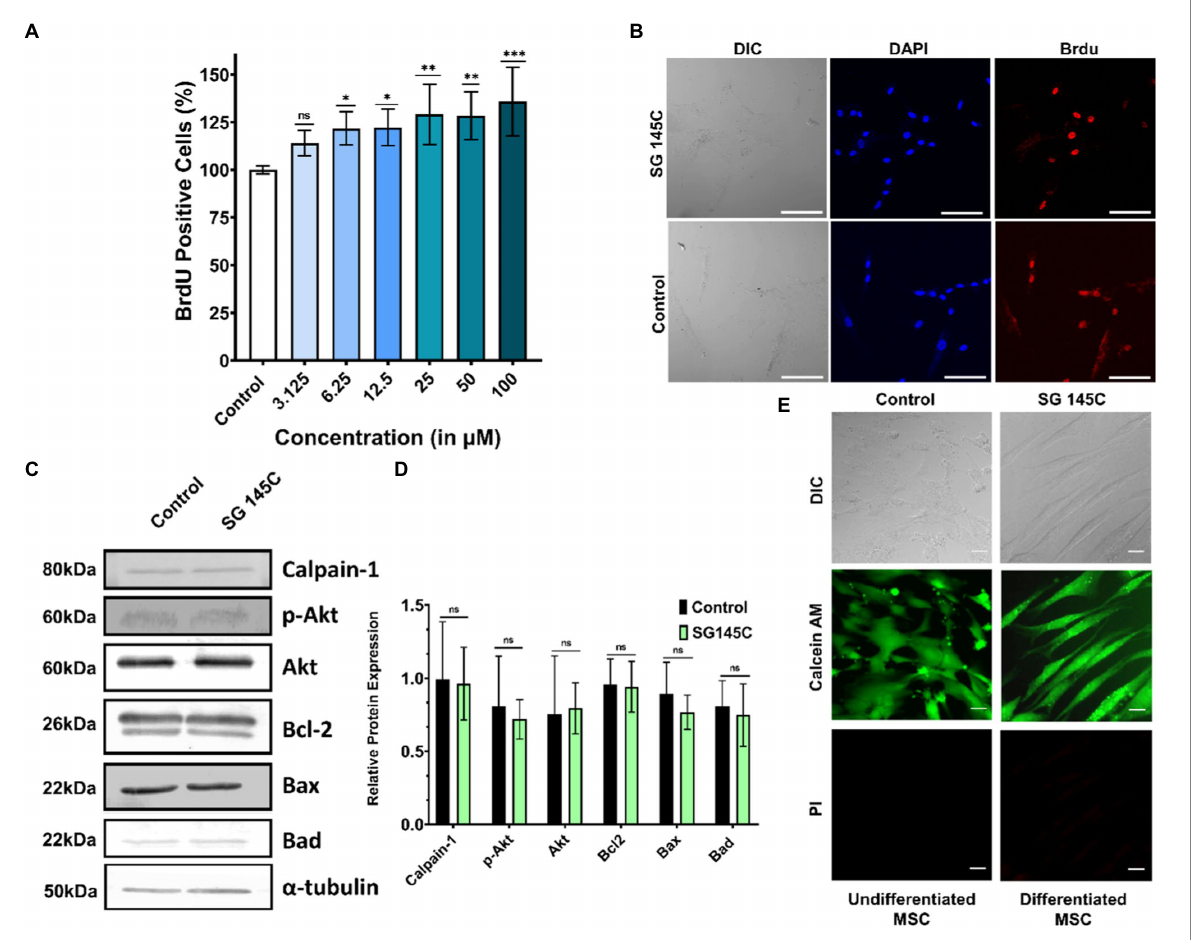
FIGURE 5 Cell proliferation and survival. (A) BrdU proliferation assay to assess the actively proliferating cells after the treatment of SG-145C in a dose- dependent manner. n > 3 in all data sets and significance was calculated using one-way Anova. (B) Immunocytochemistry to check the BrdU positive cells. Images were captured in 20X magnification where the scale bar corresponds to 70 μm. (C) Immunoblots of apoptotic and survival genes to check the homeostasis status of differentiated neurons followed by its (D) densitometric analysis. (E) Live-Dead cell assay using Calcein AM and PI. Images were captured in 40X magnification where the scale bar corresponds to 20 μm. * p < 0.05; ** p < 0.01; *** p < 0.001.